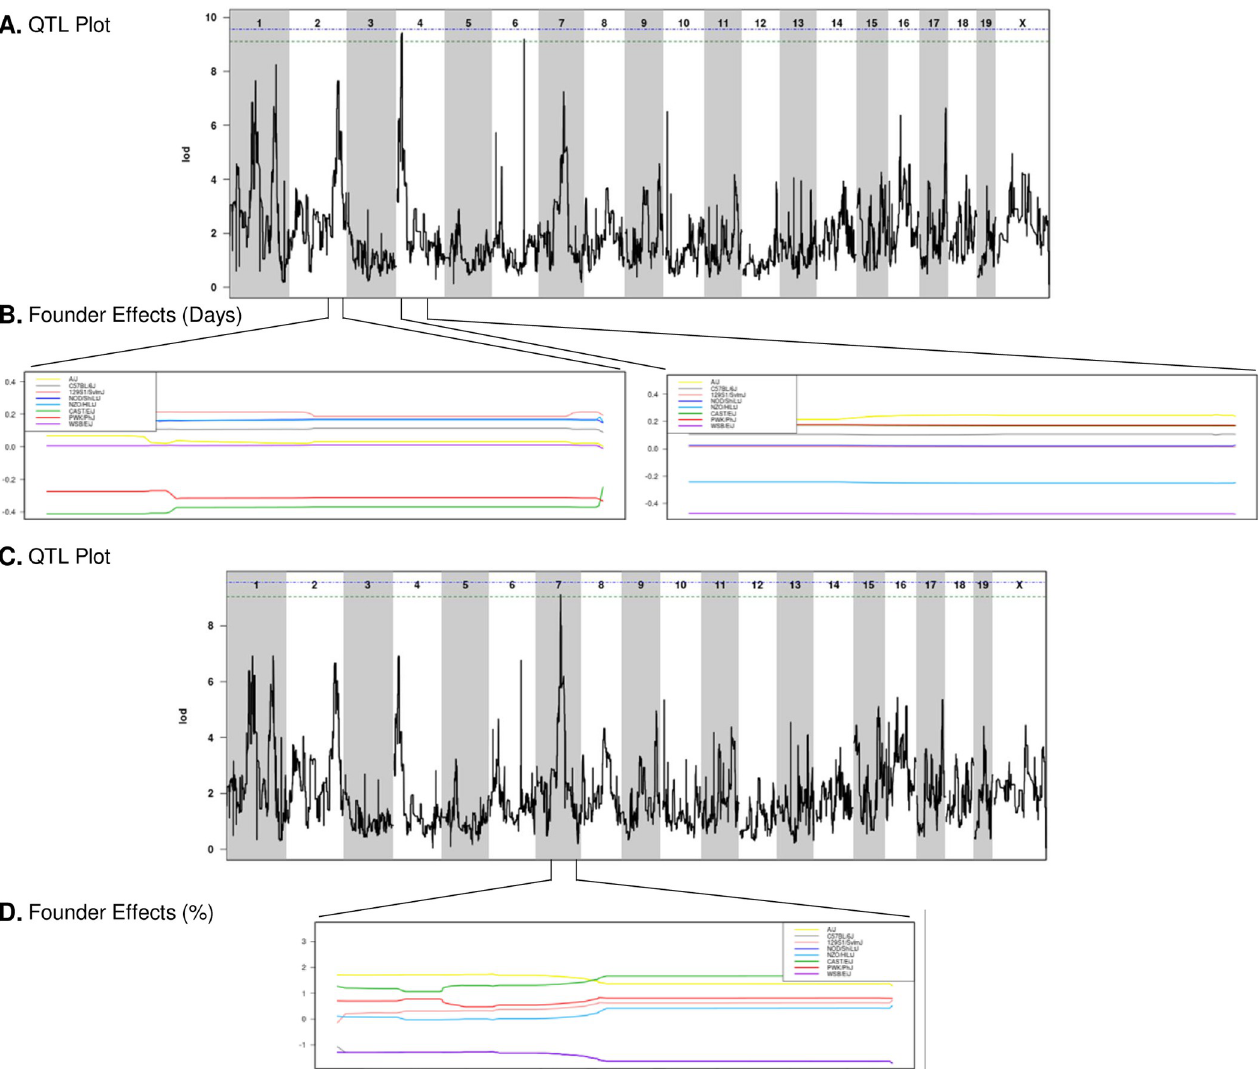
Fig 6. QTLs for survival and percent of mice surviving identified using 30 CC strains. A. QTL of median time survived after infection and B. allele effect plots focused on Chr 2 and Chr 4. C. QTL of percent of mice surviving to day 7 and D. allele effect plots focused on Chr 7. Green line designates 85% significance, blue line designates 90% significance. Results obtained using